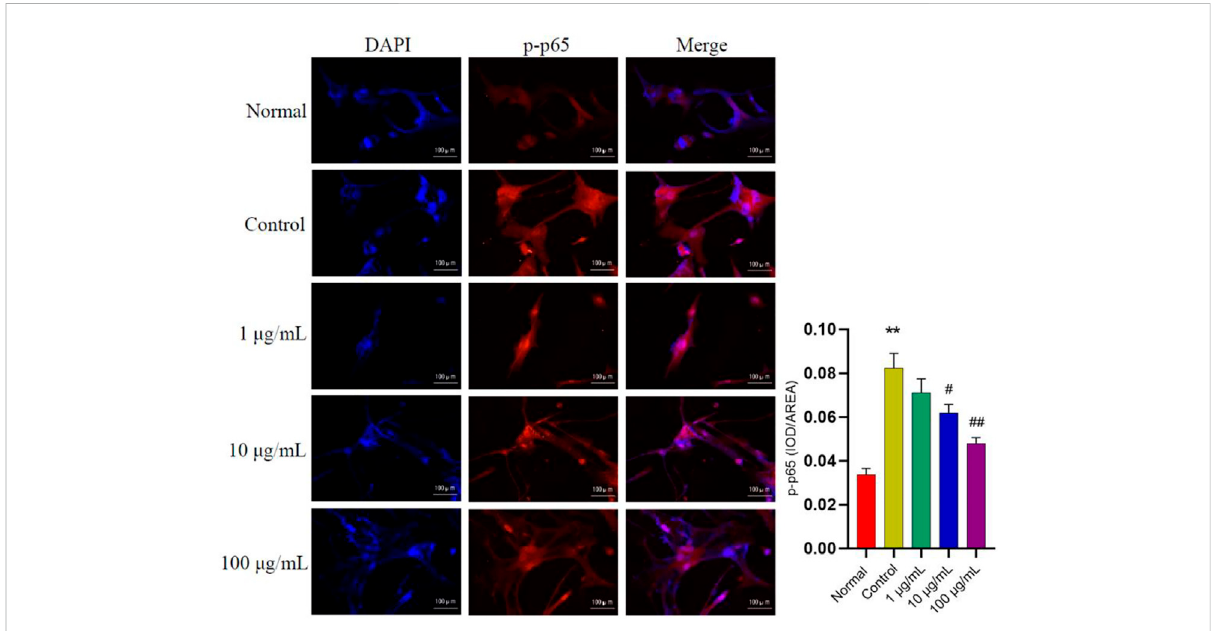
The effects of FTAs on expression of p-p65 in the nucleus of TNF- α -induced MH7A cells. MH7A cells were intervened by corresponding concentrations of FTAs in absence or presence of 20 ng/ml TNF- α for 24 h, and then the immuno fl uorescence of p-p65 in the nucleus were photographed by Nikon fl uorescence microscope system. The experimental results were recorded as mean ± SD ( n = 3). * p < 0.05, ** p < 0.01 vs normal, # p < 0.05, ## p < 0.01 vs.